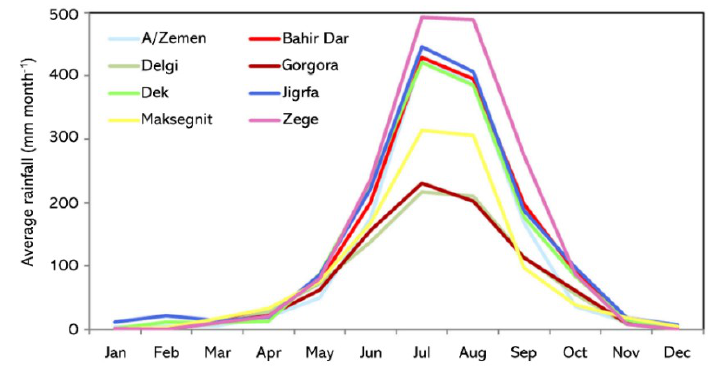
Figure 4. Long term average monthly rainfall for 1990–2014 of the eight stations used in calculating the precipitation for Lake Tana.